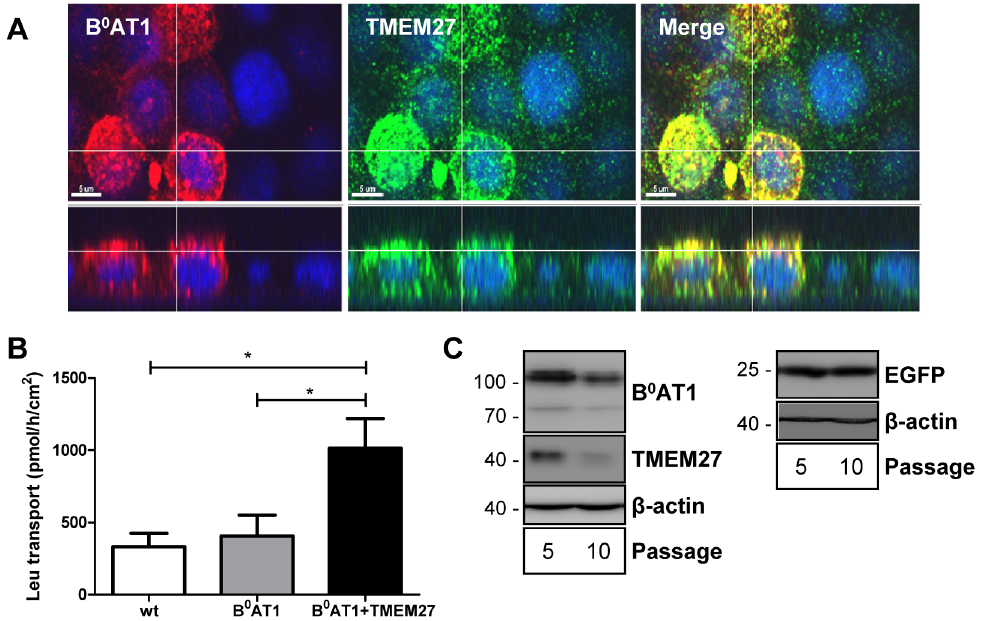
Figure 1. Overexpression of B 0 AT1 and TMEM27 in MDCK cells. A: immunofluorescence analysis of B 0 AT1-TMEM27 overexpressing MDCK cells. Apical co-localization (yellow) of B 0 AT1 (red) and TMEM27 (green) is visualized by confocal microscopy. Upper panels represent images taken parallel to the filter (x–y plane); lower panels show corresponding z–x reconstitutions. Bars =5 m m. B: Apical uptake of L-Leu (100 m M, 10 min) in wild type (wt) or B 0 AT1 or B 0 AT1-TMEM27 overexpressing MDCK cells cultivated on filters. Data are represented as mean 6 SEM (n=3). Groups were compared by one-way ANOVA followed by Tukey post-test; * p # 0.05. C: MDCK cells overexpressing B 0 AT1-TMEM27 or EGFP. After viral transduction, cells were subcultured on plastic dishes for 5 or 10 times (passage 5 and 10, respectively) in standard cell culture medium. Western blotting experiments with antibodies directed against B 0 AT1, TMEM27 and EGFP were performed. Representative Western blotting images of 3 independent experiments are